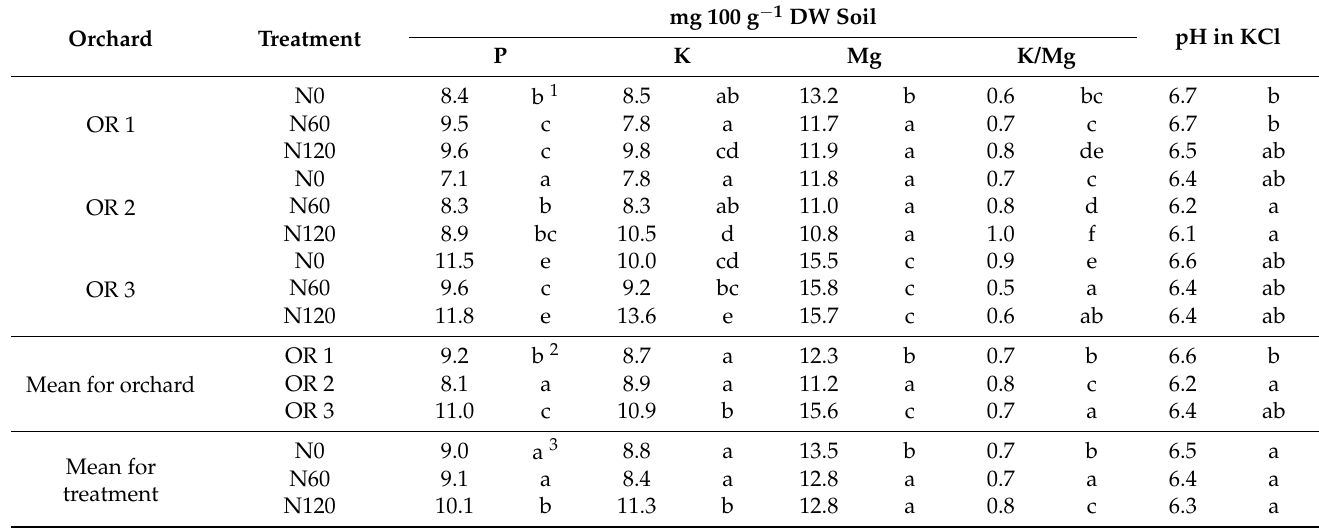
Table 4. The influence of nitrogen fertilization on the content of P, K, and Mg nutrients and on pH in 2010–2013 in depth 0–20 cm.